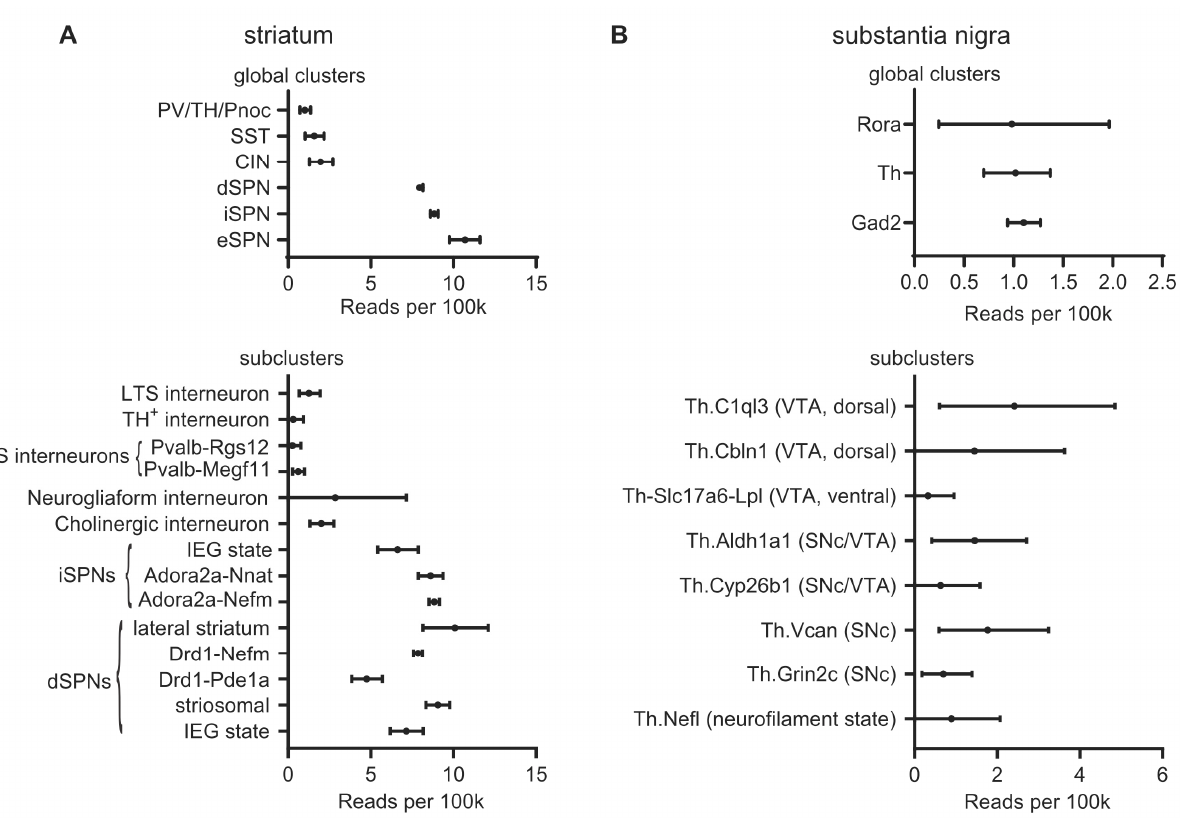
Figure 1. Single-cell LRRK2 mRNA levels. Single-cell LRRK2 mRNA expression data from dropviz.org for selected types of striatal neurons and dopaminergic midbrain projection neurons. ( A ) Top: LRRK2 mRNA expression in global clusters defining striatal neuron types. LRRK2 mRNA is more abundant in SPNs than in striatal interneurons. Bottom: Subclusters selected on the basis of their putative identity with well-characterized subpopulations of striatal neurons (i.e., excluding eSPNs and clusters which had been identified as non-striatal neurons). Cell cluster identities are as described by Saunders et al., except Neurogliaform interneurons, which was assigned based on the expression of NPY but not parvalbumin, somatostatin, or Nos1, as defined by Tepper et al. [62]. Some subclusters of fast-spiking interneurons and SPNs do not correspond to a well-characterized